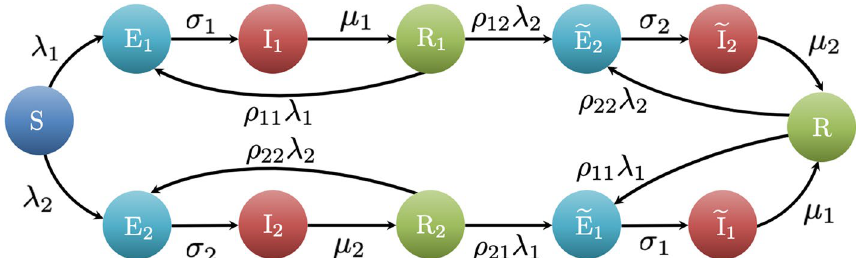
Fig. 1 Progression of a virus spread with two strains. The diagram describes the transitions that each individual undergoes between health states. All parameters are constant and represent transition probabilities or